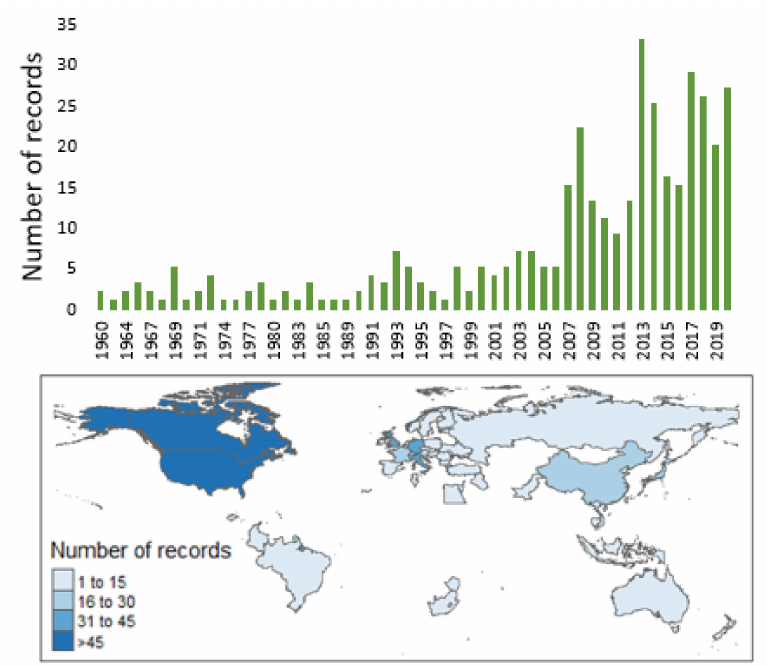
Figure 1. Number of articles published annually from 1960 to 2020 (barplot) and their distribution across countries (world map), according to the Web of Science request formulated on 30 March 2021 as follows: (wireworm* OR (click AND beetle*) OR agriotes) AND (IPM OR biocontrol OR control OR management OR regulation OR “risk assessment” OR “decision support” OR DSS). A total of 386 articles were published over the period under study, with a sharp rise around